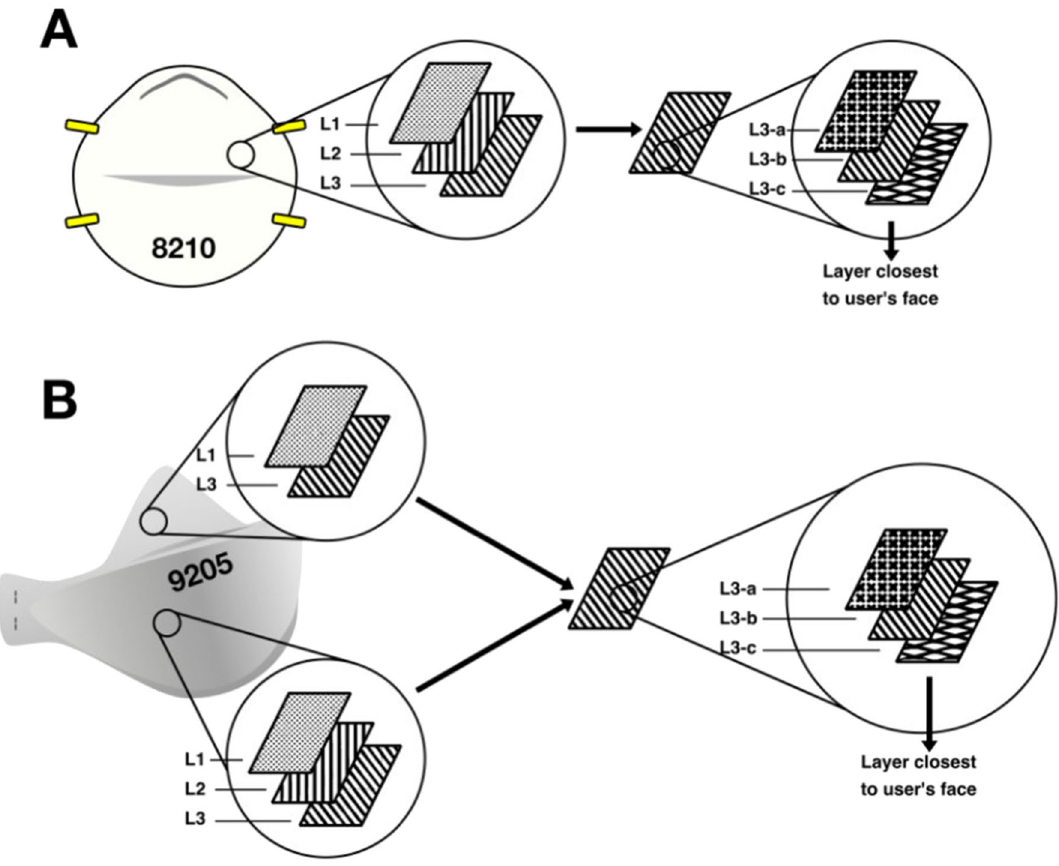
Figure 1. ( a ) N95 8210 layer arrangement, ( b ) N95 9210 layer arrangement. Note that side sections of the 9210 respirators lack an L2